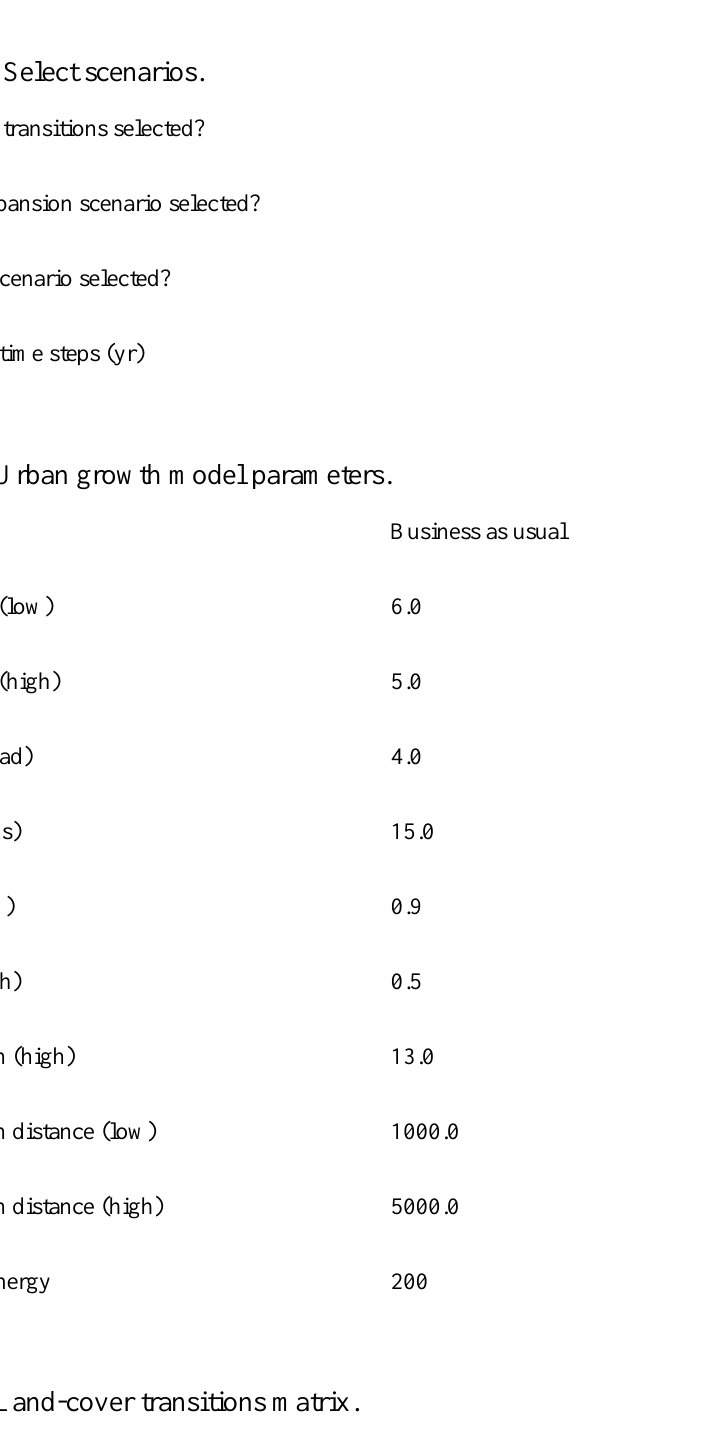
Table A. Select scenarios.